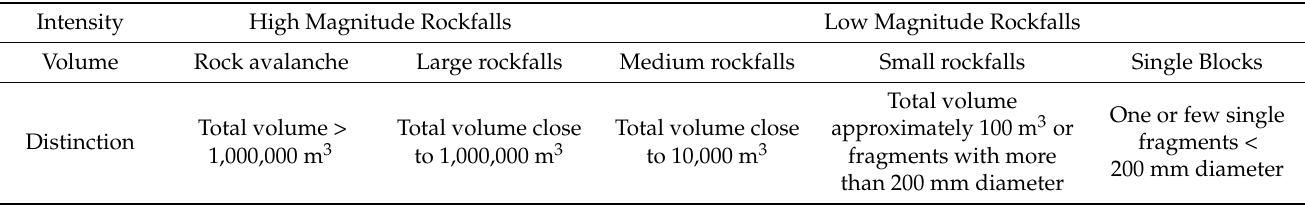
Table 2. Rockfall intensity, modified from